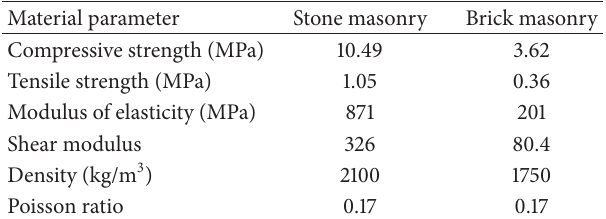
Table 2: Material parameters of masonry for FE